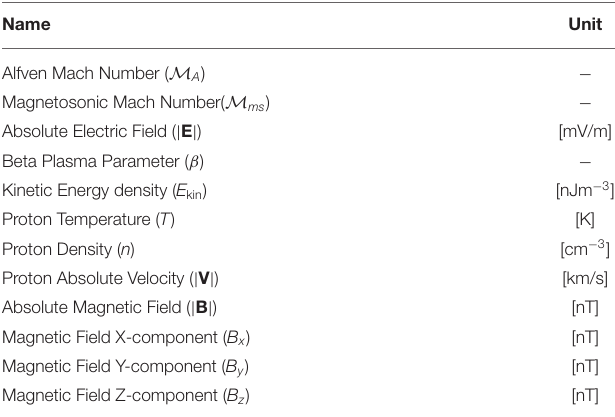
TABLE 1 | Solar wind quantities used as input to the neural